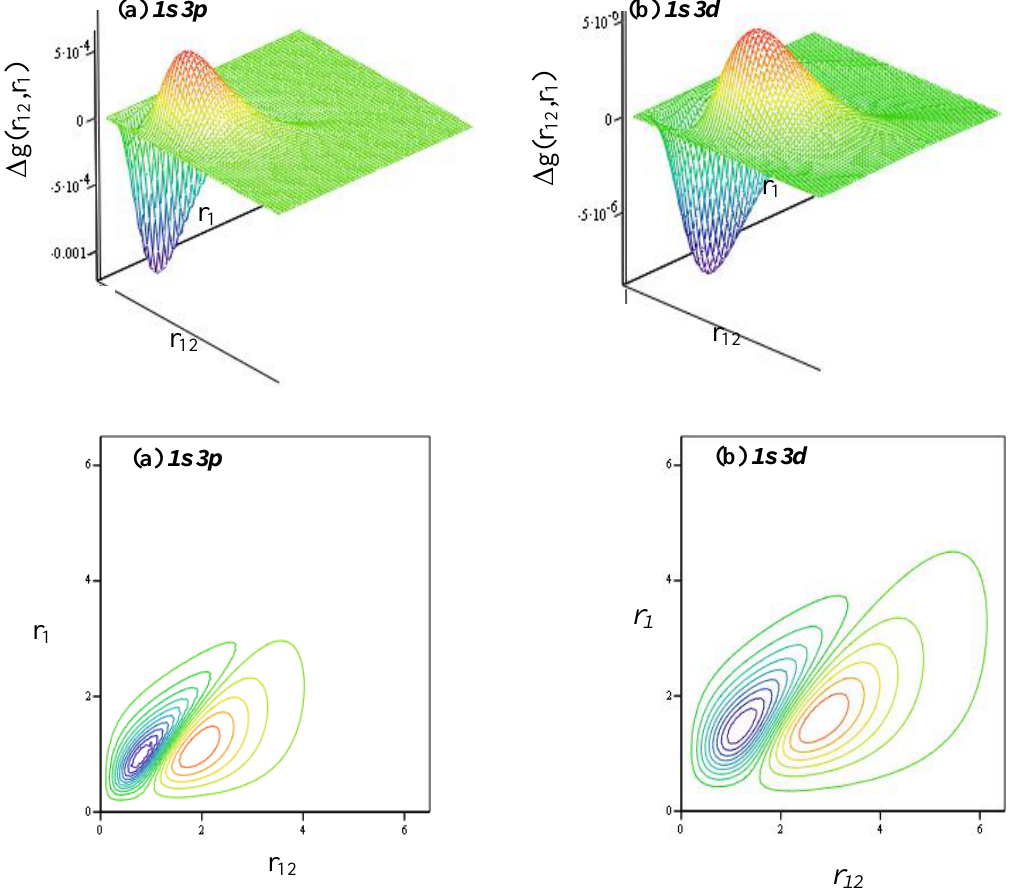
Fig. 10: The surfaces and contours of the partial Fermi hole ∆g(r g (r ,r )-g (r ,r ) for Li- atom in different excited states (a) 1s 3p and (b) 1s αα 12 1 βα 12 1